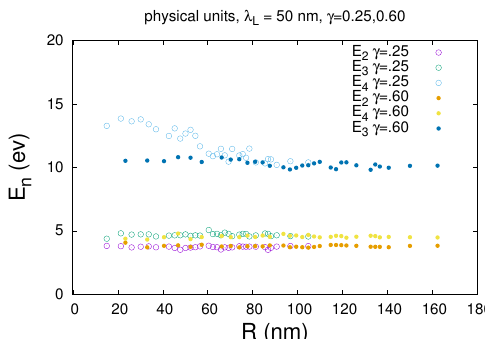
physical units, λ L = 50 nm, γ =0.25,0.60